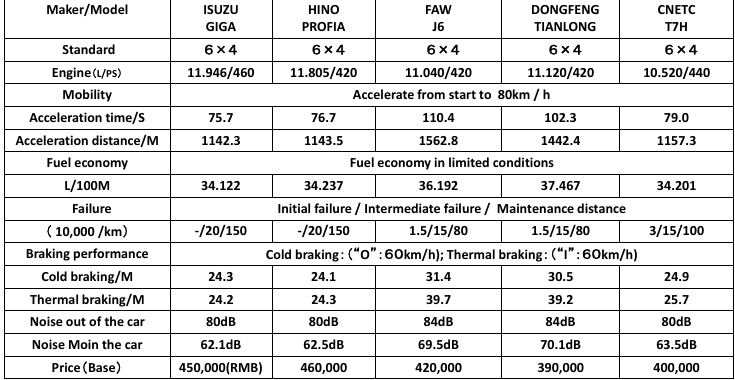
Table 3. Isuzu, Hino, and rival trucks